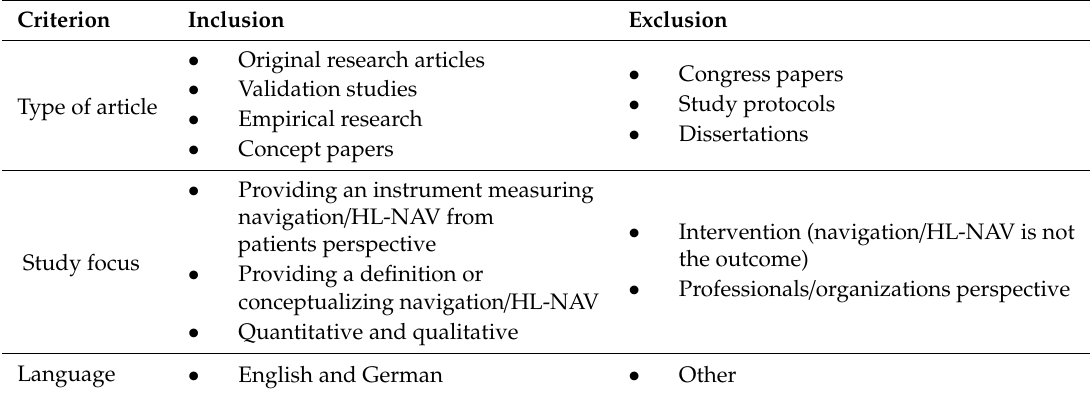
Table A1. Inclusion and exclusion